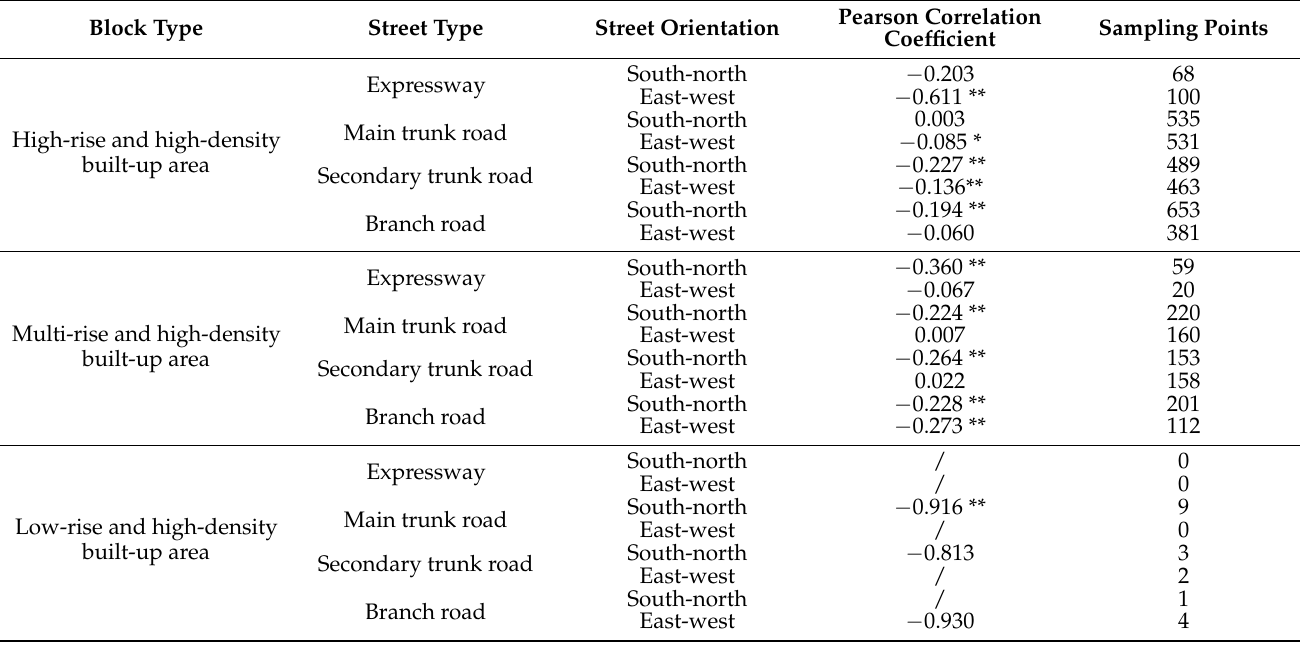
Table 3. The correlation coefficient between the streets’ SGR and LST at different types.